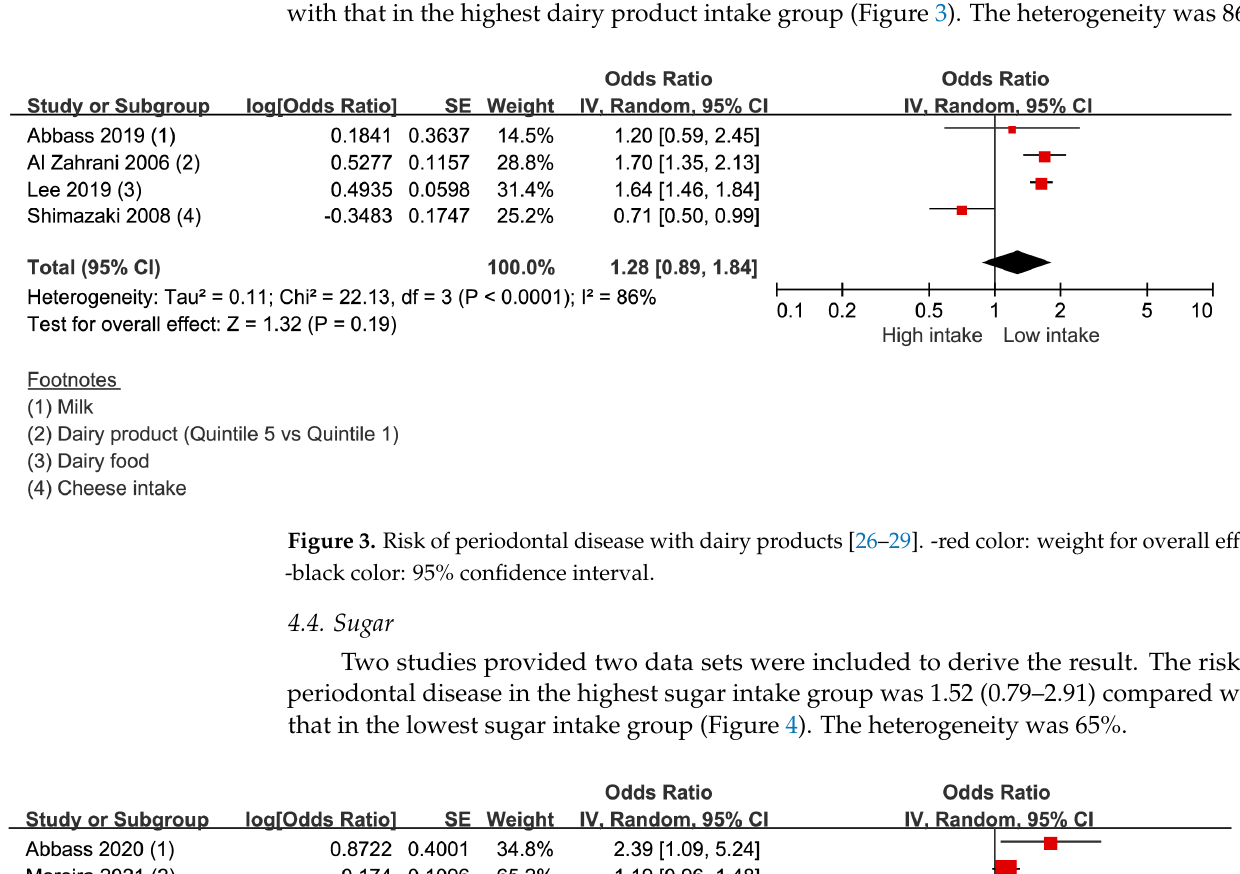
Figure 2. Risk of periodontal disease with the western diet [24,25]. -red color: weight for overall effect ;-black color: 95% confidence interval